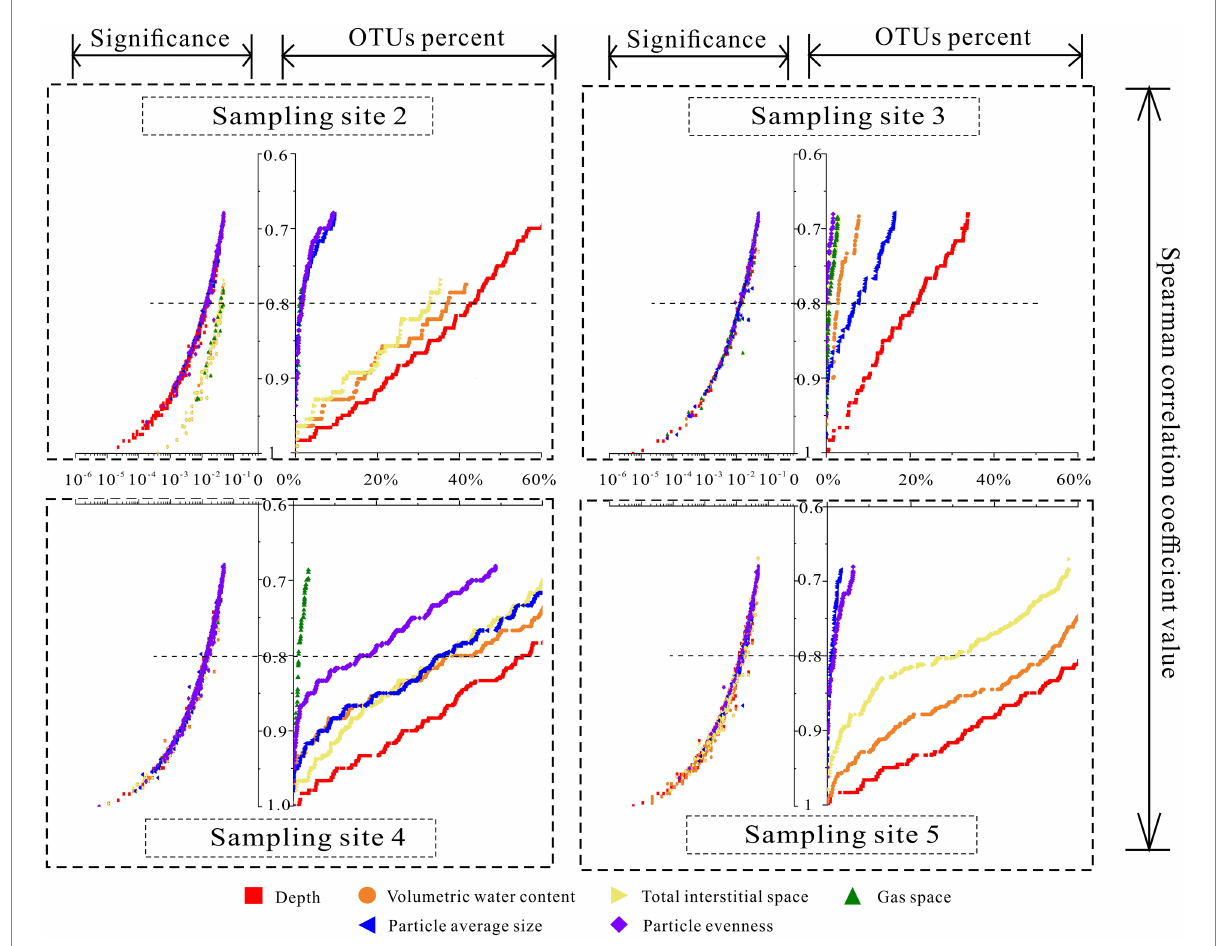
FIGURE 5 The variations of the correlations among interstitial space features and relative abundance of correlated